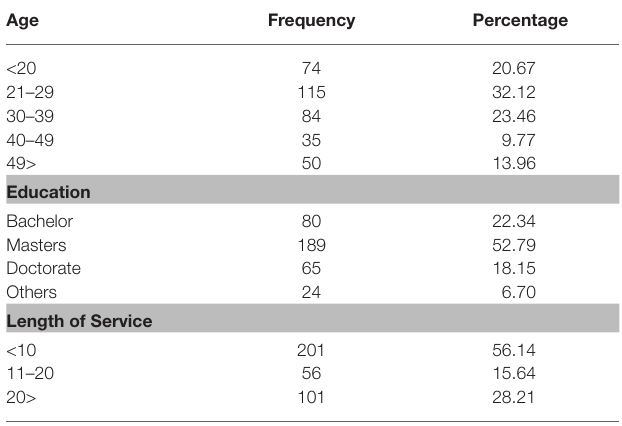
TABLE 1 | Demographics of the